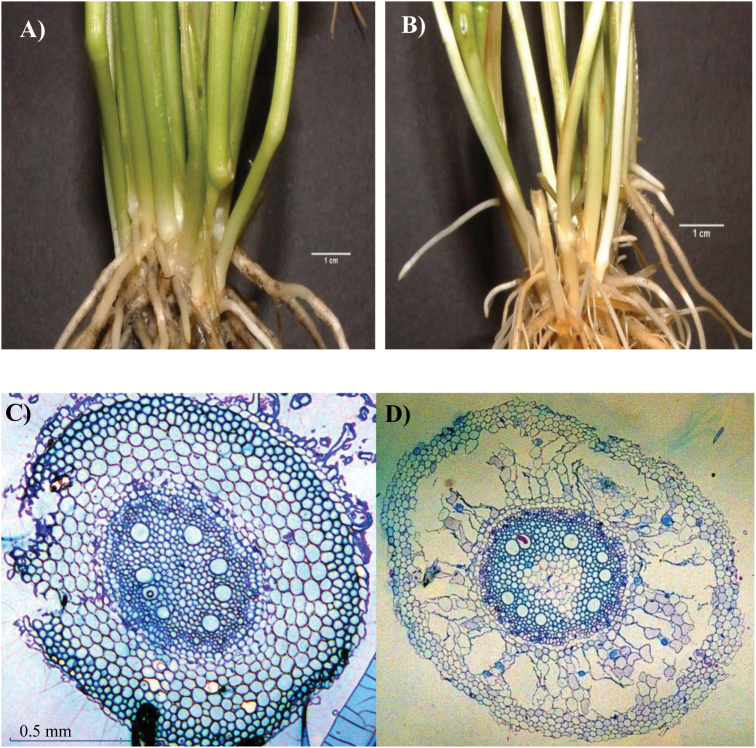
Emergence of surface adventitious root and aerenchyma formation. Comparison of surface adventitious root emergence in control (A) and waterlogged (B) plants at 28 d after waterlogging. Lateral sections of control (C) and 28 d waterlogged (D) nodal root segments (4 cm from the root apex) at ×4 magnification. Aerenchyma formation is evident in the cortical cells of roots waterlogged for 28 d.